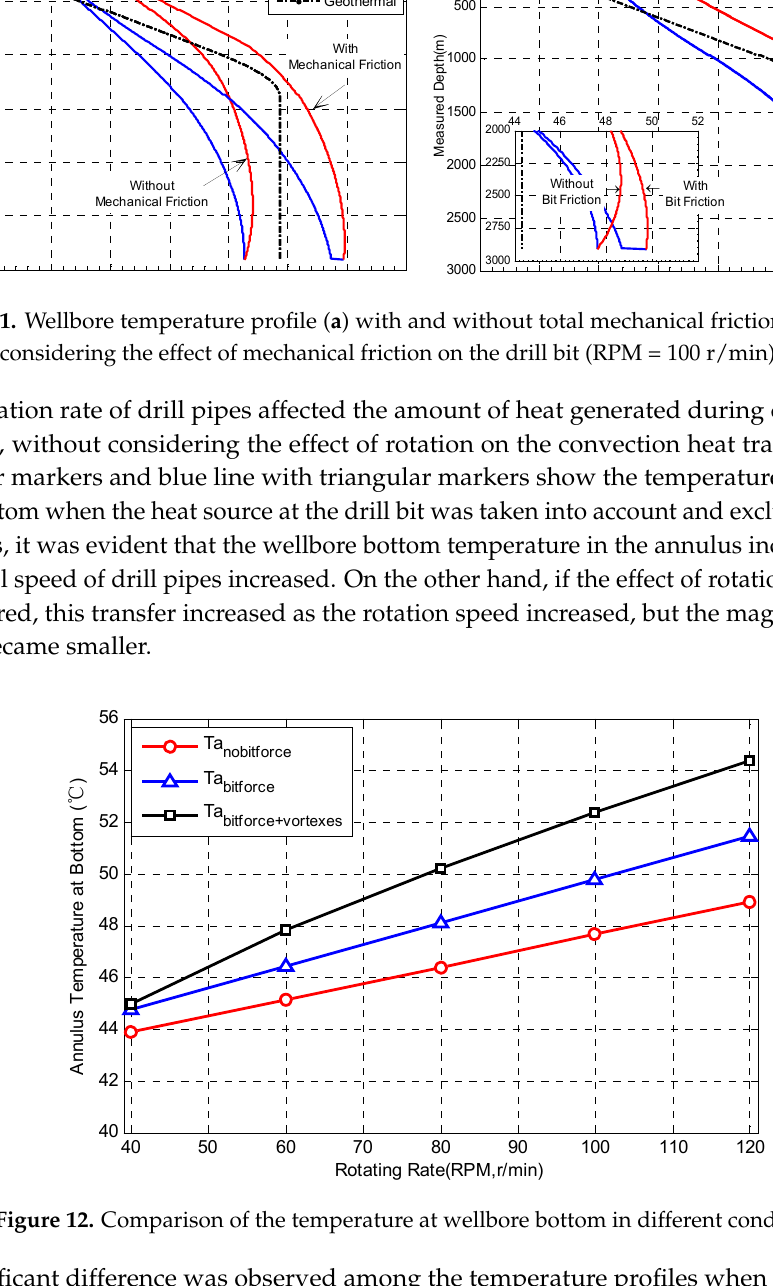
Figure 12. Comparison of the temperature at wellbore bottom in different conditions.